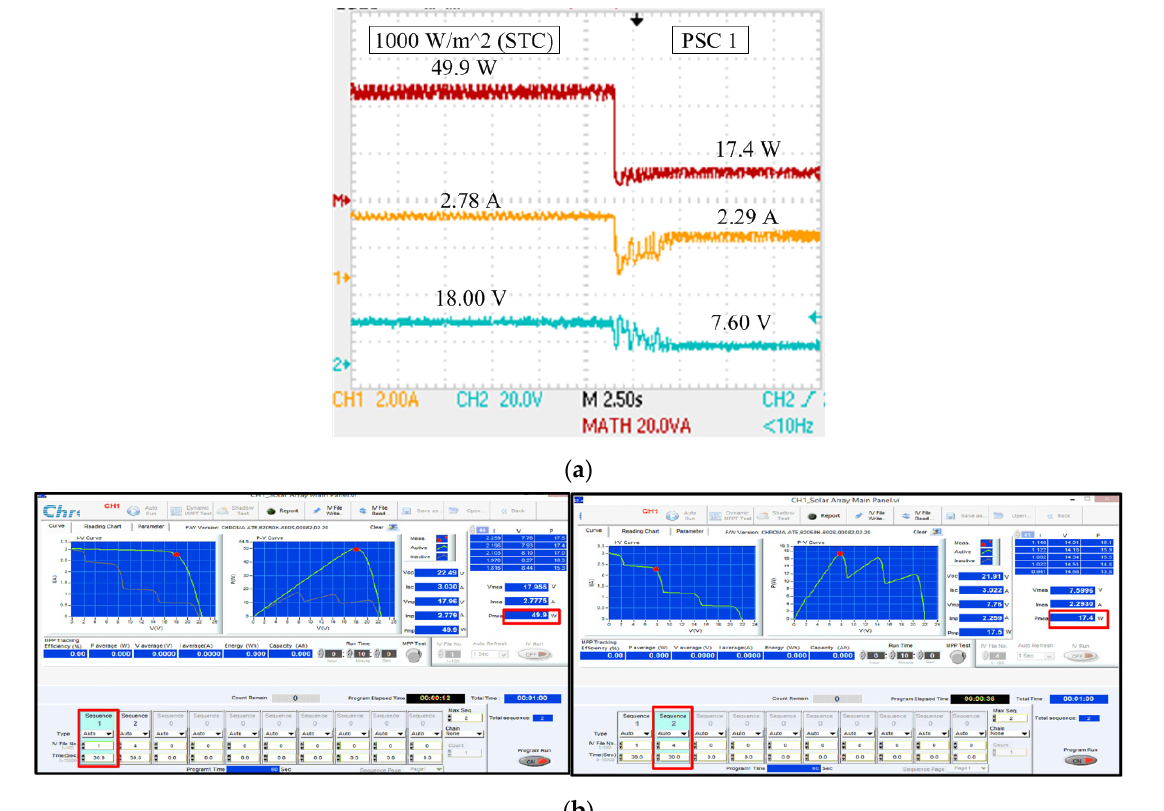
Figure 27. Dynamic changes from 1000 W/m 2 to PSC 1 for the proposed modified LFO, ( a ), ( b ), reflect same result. Table 5. Details of the proposed modified LFO algorithm.